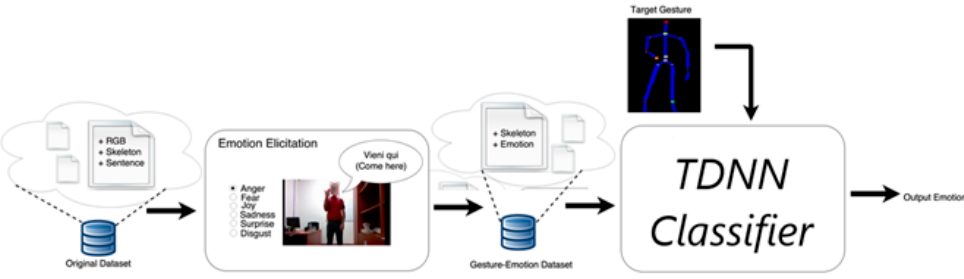
Figure 2. High-level representation of the proposed methodology.